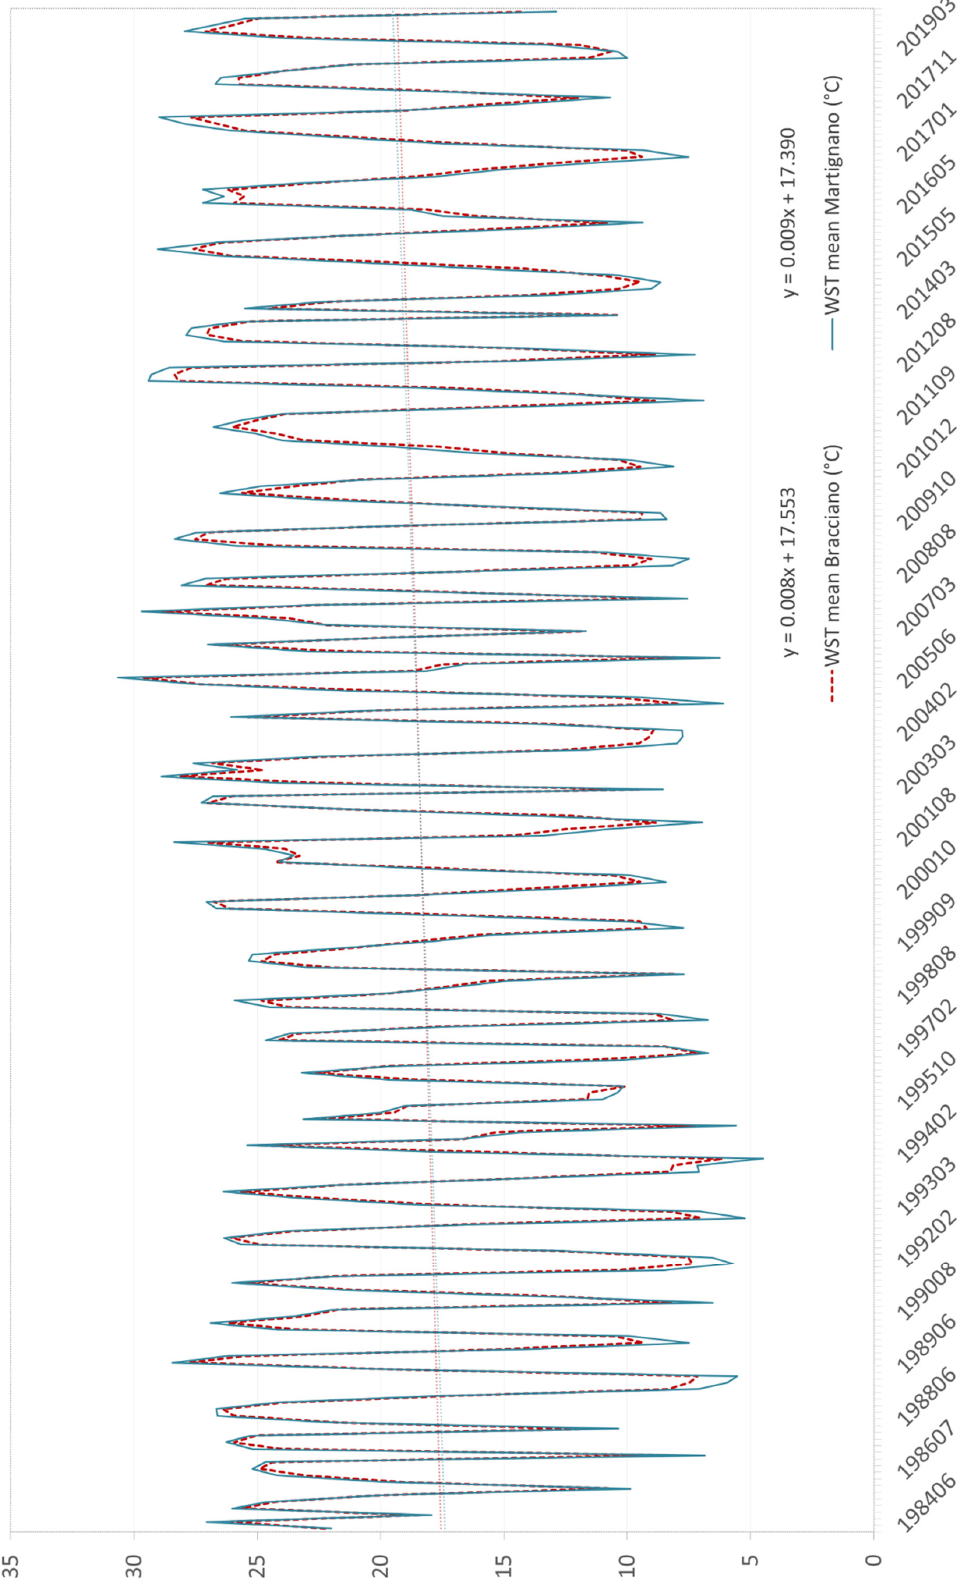
Figure 5. Monthly averaged WST derived from Landsat with a linear regression model for atmospheric correction products (“method 2”) from 1984 to 2019 for Lake Bracciano (red) and Lake Martignano (light blue).